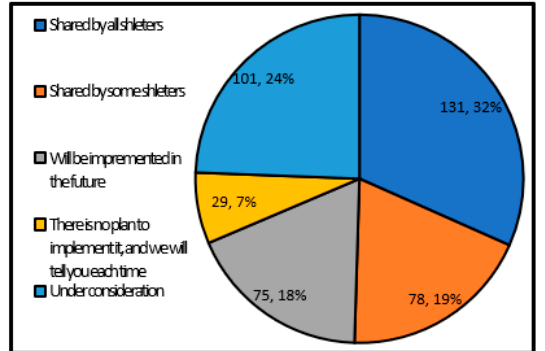
Figure 12. Sharing the awareness of the shelter operation manager (single answer) (Single answer, total number of answers 414, total number of local governments: 414, unit: group).